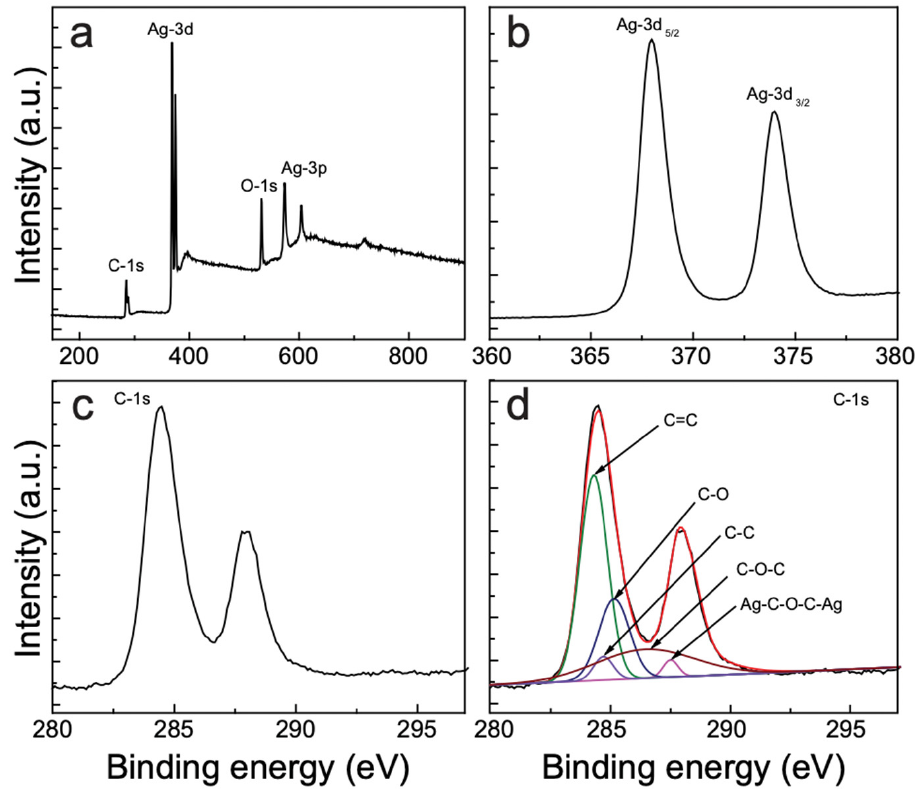
Figure 4. XPS profiles of ( a ) the survey scan, ( b ) Ag-3 d , ( c ) C-1 s , and ( d ) the deconvoluted C-1 s peaks for the AgNP–CNS nanocomposite.